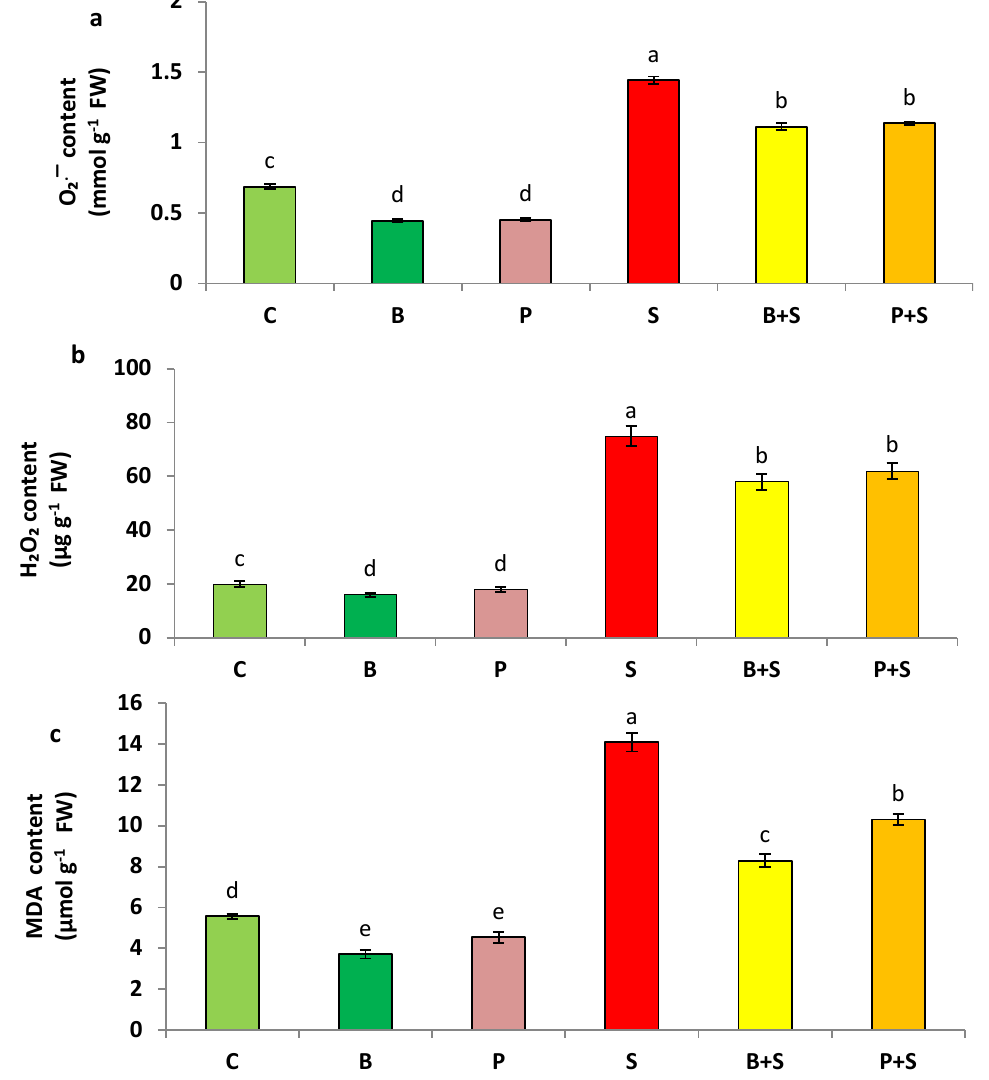
Figure 1. Effect of BABA and PEG seed priming on superoxide ( a ), hydrogen peroxide content ( b ), and lipid peroxidation ( c ) in cowpea seedlings exposed to PEG stress. C (control), B (BABA-primed seedlings without any stress), P (PEG-primed seedlings without any stress), S (unprimed seedlings subjected to PEG stress), B + S (BABA-primed seedlings subjected to PEG stress), P + S (PEG-primed seedlings subjected to PEG stress). Values represent the mean ± SE of three independent experiments. Alphabetical letters show significant difference between treatments performed using Duncan’s multiple range test.